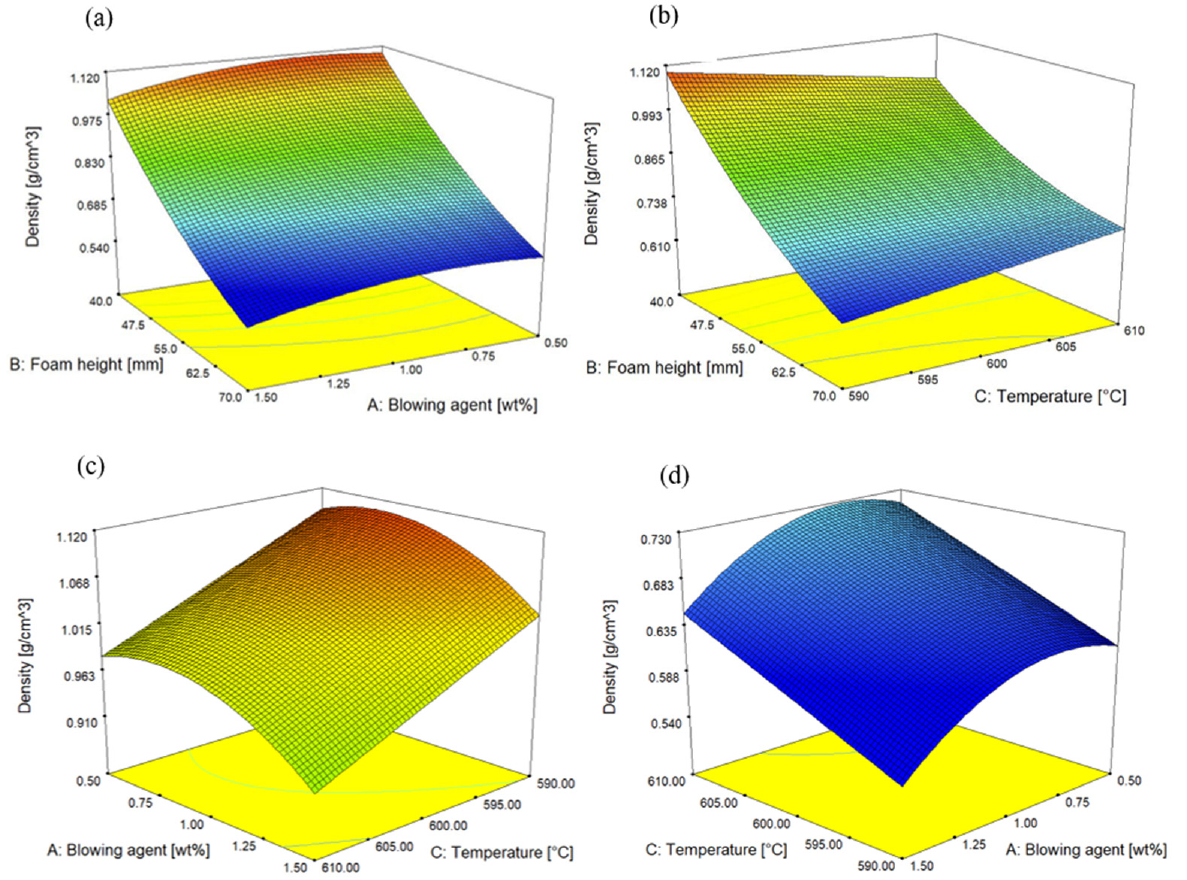
Figure 5. ( a ) Influence of foam height and blowing agent (wt%) on foam density for constant foaming temperature of 590 ◦ C. ( b ) Influence of foam height and foaming temperature on density for 1 (wt%) TiH 2 . ( c , d ) Influence of the foaming temperature and blowing agent (wt%) for constant foam heights of 40 mm and 70 mm, respectively.